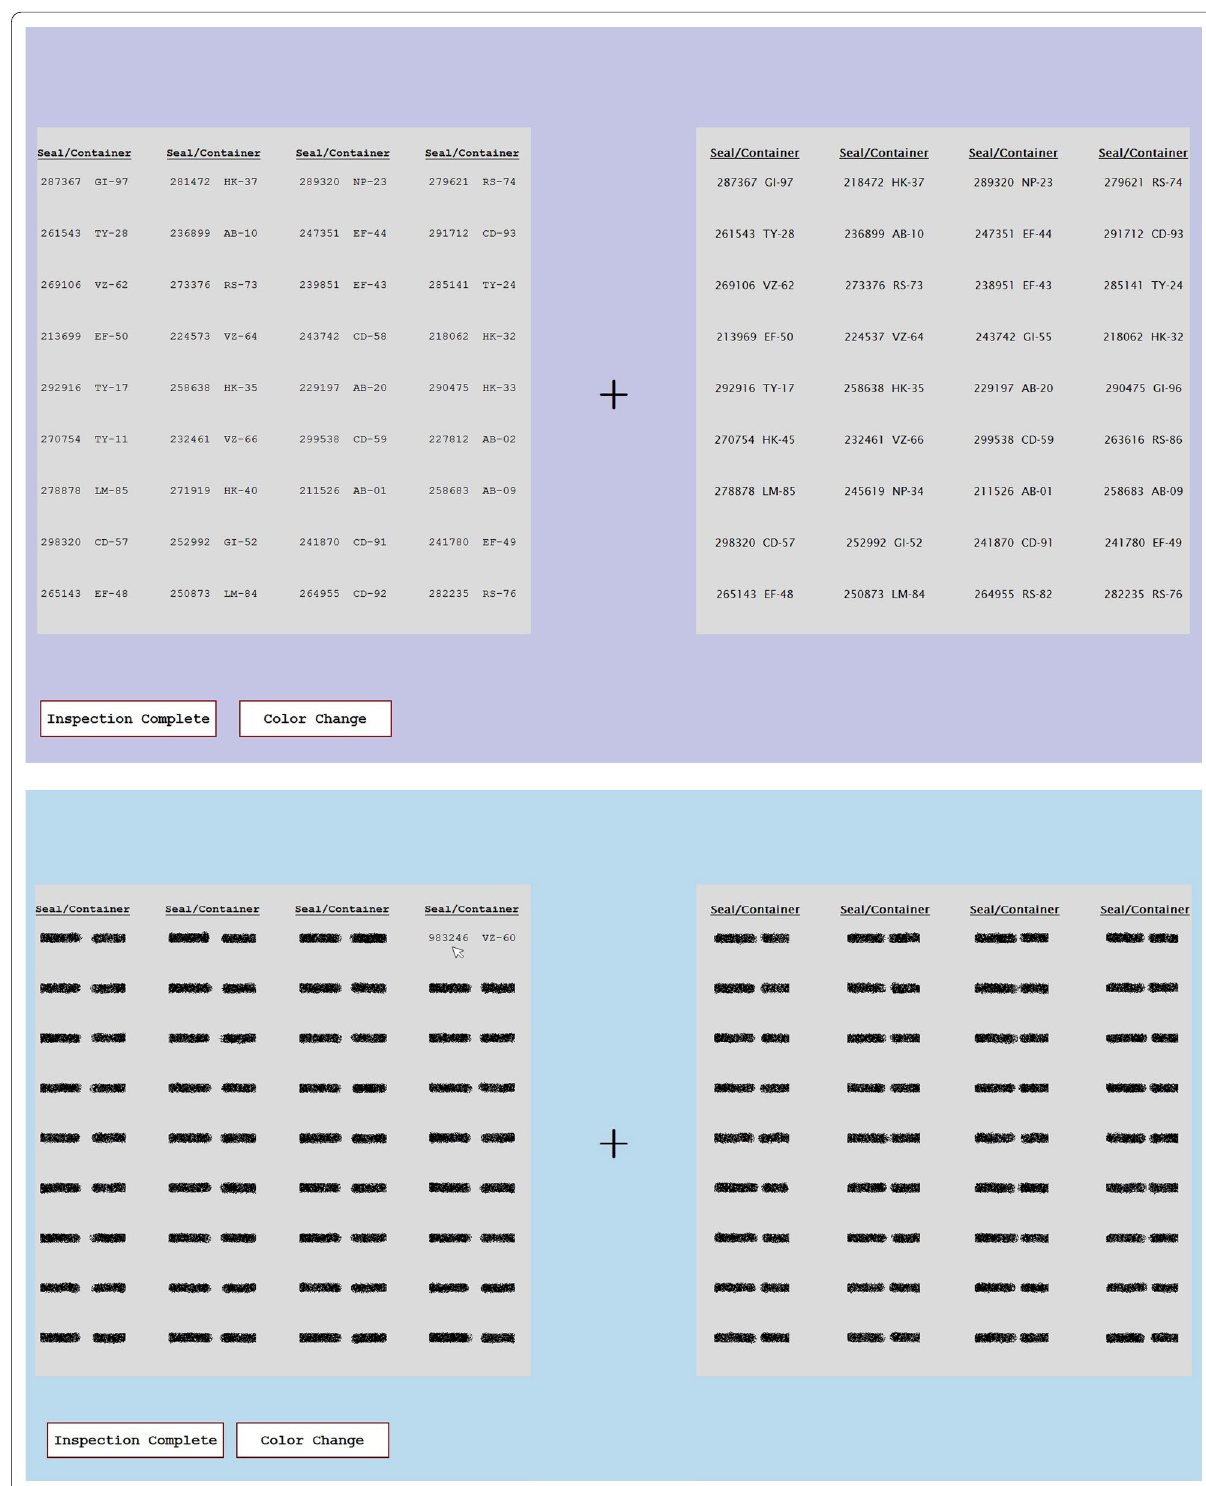
Fig. 1 Examples of the stimulus display for the eye tracking (top) and artificial foveation (bottom) experiments. These screen shots show how the stimuli appeared to the participants in each